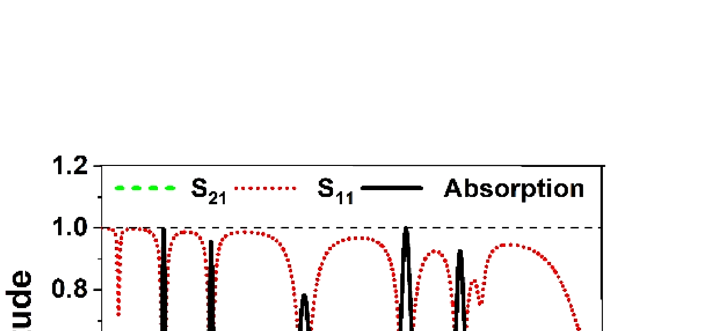
Figure 15. ( a ) Variation of S 21 change of ground plane height. ( b ) Variation of S 11 for the various ground plane of height. ( c ) Variation in absorption property with the backplane of different heights.